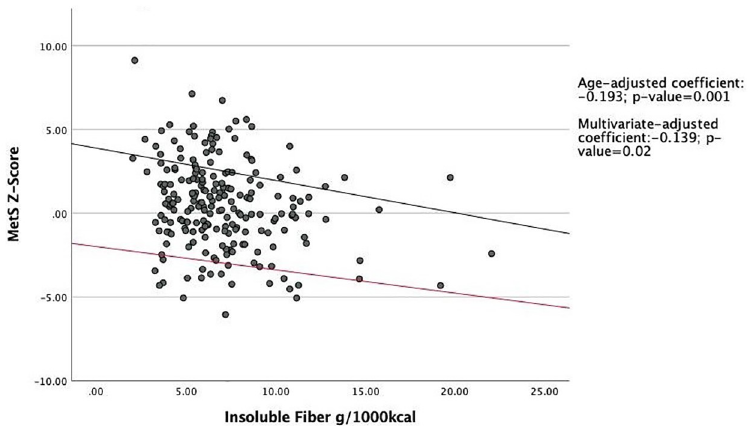
Fig 3. Association between insoluble fiber intake and MetS Z-score. Abbreviations: MetS, Metabolic Syndrome. Linear regression model was used to predict association between insoluble fiber intake and MetS z-score. The black regression line indicates age-adjusted linear regression, for which the coefficient is -0.193. The red line indicates multivariate-adjusted regression, for which the coefficient is -0.139. Means were adjusted for age, BMI, smoking, education, marital status, total physical activity, and total energy intake. Both lines are statistically significant.